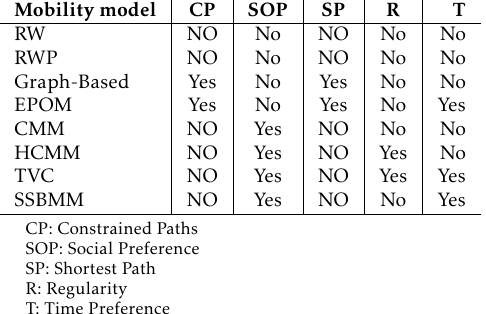
Table 1. Mobility Models and Human Mobility characteristics Mobility